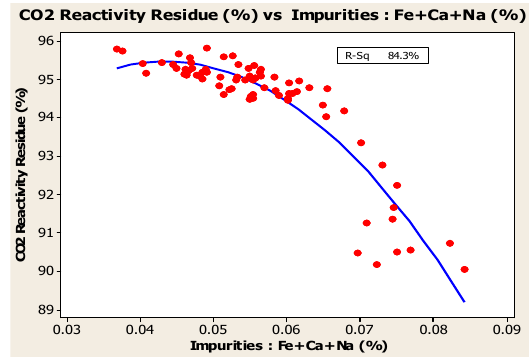
Figure 10. CO 2 RR vs. impurities.